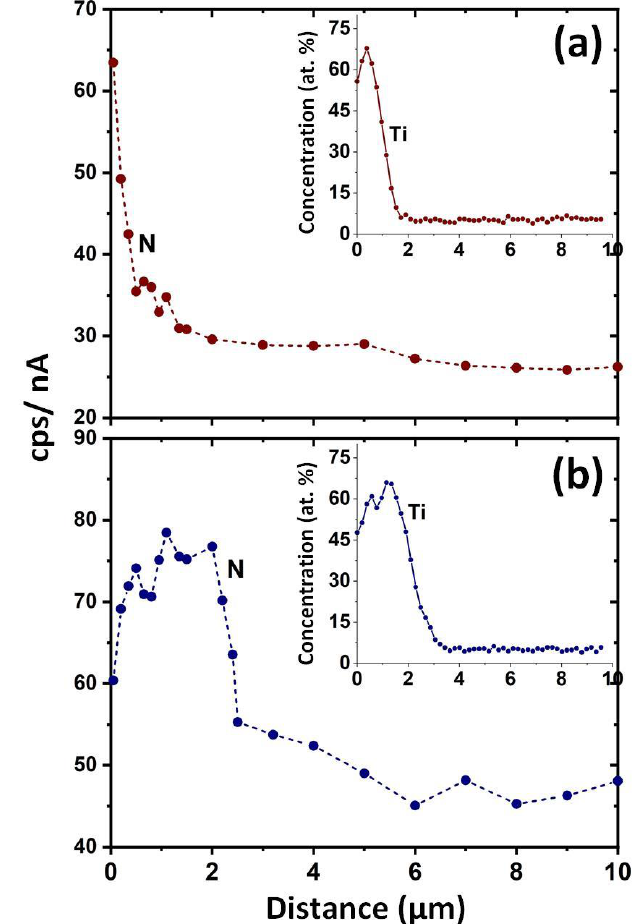
Figure 6. Typical EDS spectrum of duplex-treated samples with TiN deposition temperature of 400 °C.